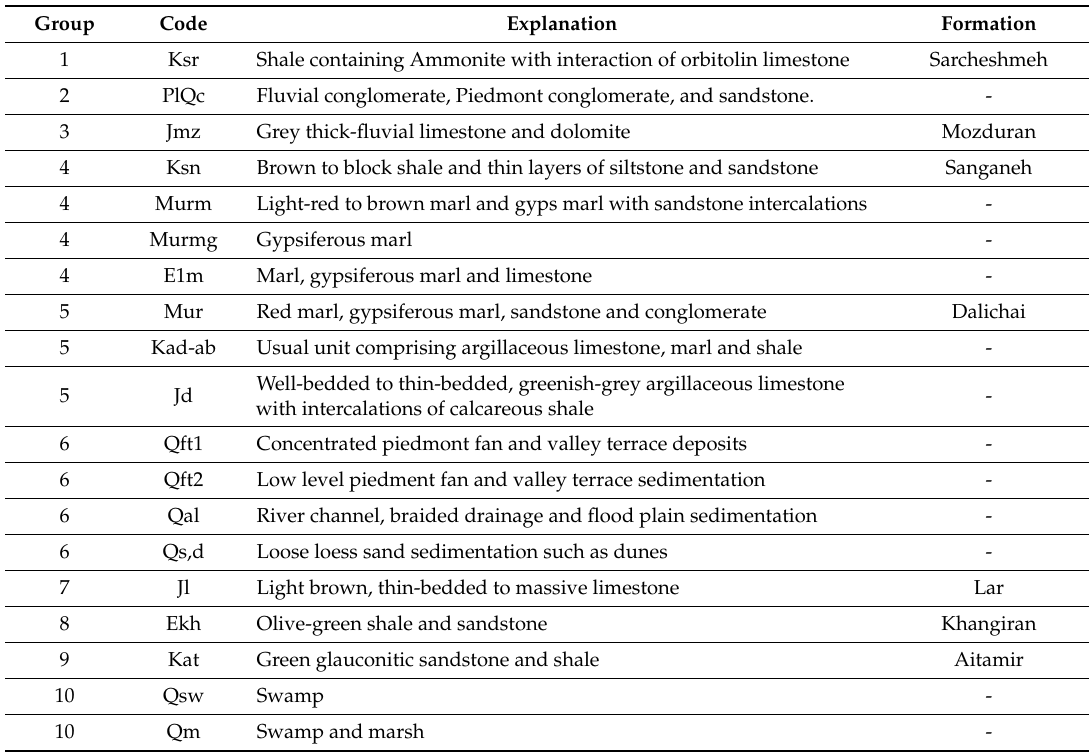
Table 1. Lithology of the Gorganrood